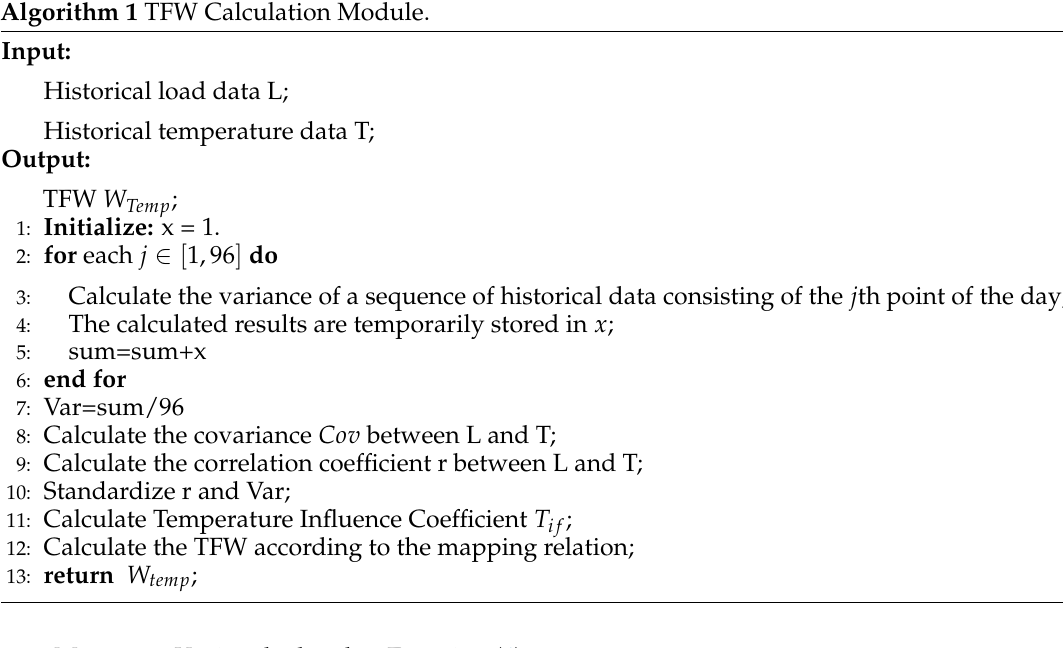
Figure 4. Structure of Temperature Factor Weight Calculation Module. Algorithm 1 TFW Calculation